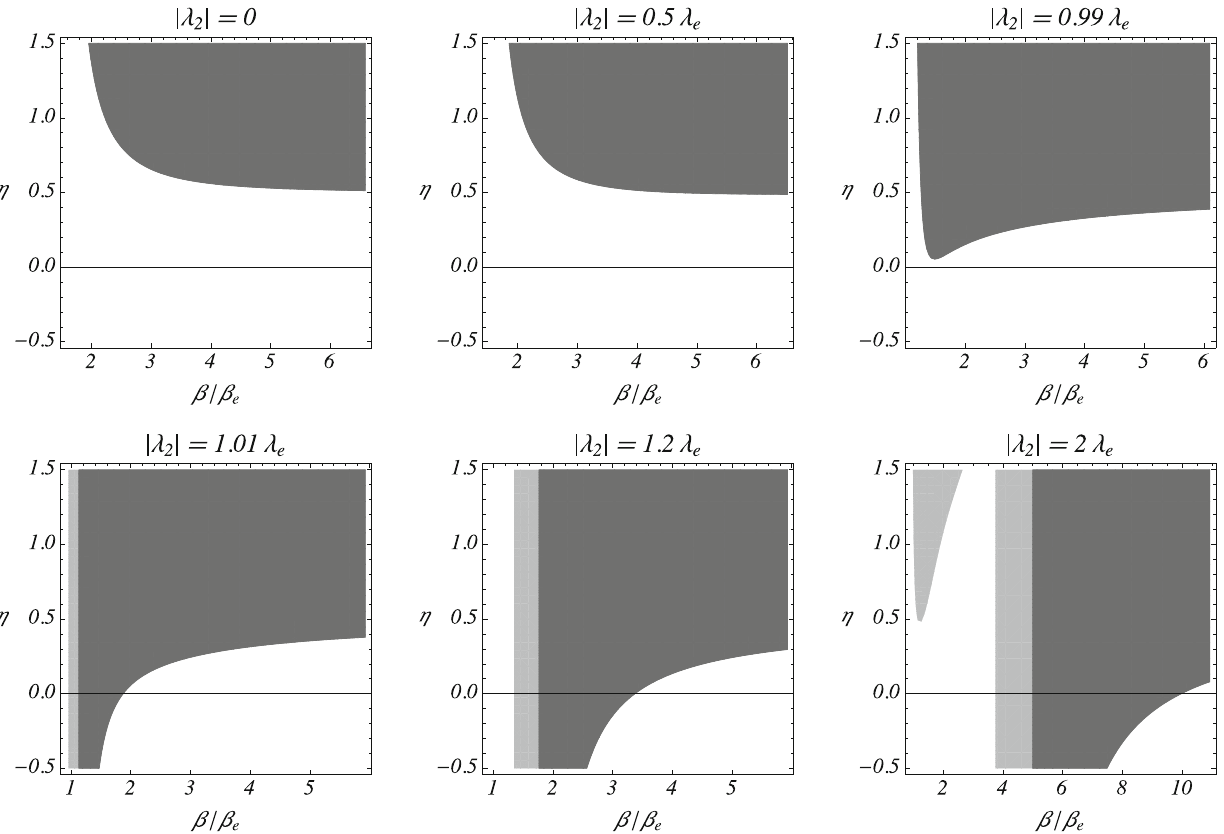
Fig. 2 Stability regions (light and dark grey) for charged shells with radius a 0 around black strings with m 1 > 0 and λ 1 = 0, and an exterior geometry with m 2 > 0 and any λ 2 ; the negative cosmological constant is (cid:2) for the whole spacetime. The relation between the values of the